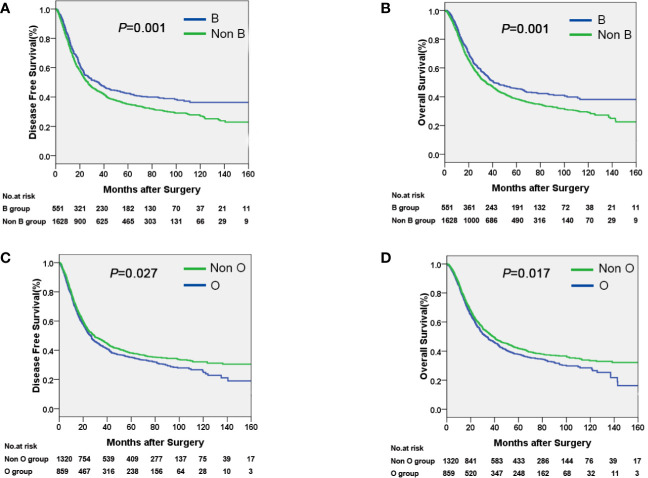
Kaplan-Meier curves showing that patients with blood type B had a longer DFS (A) and OS (B) compared with non-B patients, and that patients with blood type O had a shorter DFS (C) and OS (D) compared with non-O patients.